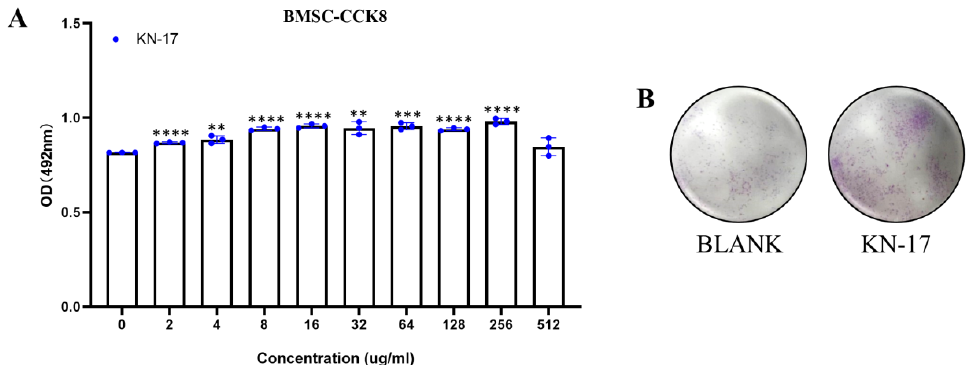
Figure 5. ( A ) CCK-8 results of hBMSCs cells when KN-17 was added to the culture for 3 days. Note: Data are presented as mean ± SD; n = 3. ** Indicates statistical significance between the BLANK group and KN-17 group. (** p < 0.01, *** p < 0.001, and **** p < 0.0001, ANOVA). ( B ) Cell proliferation was observed under electron microscope after adding KN-17.